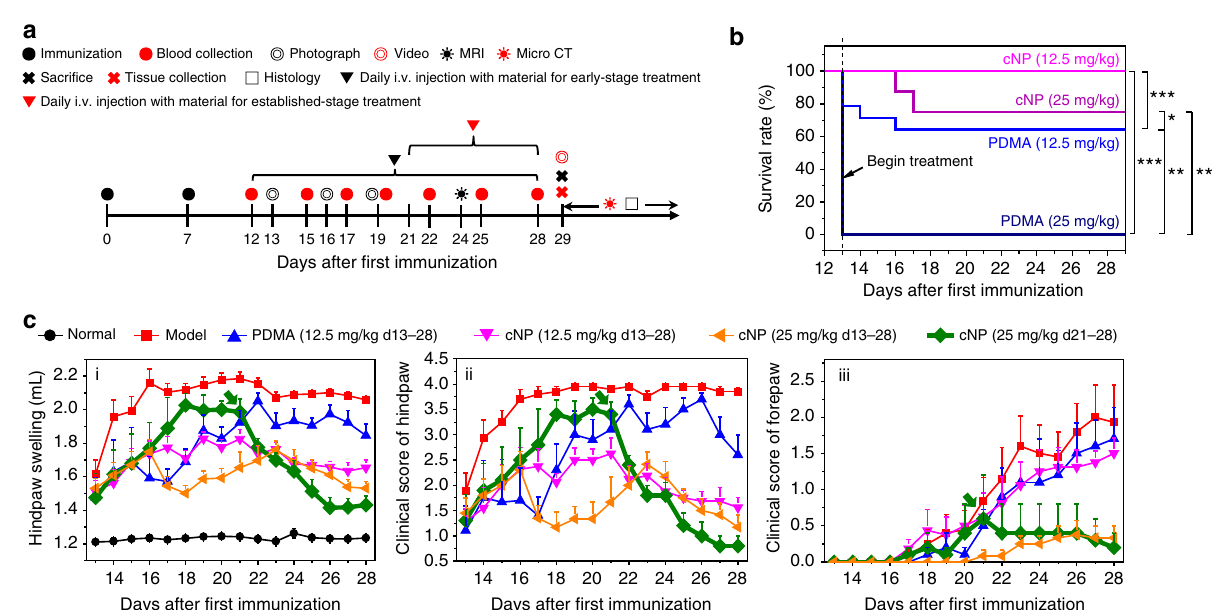
Fig. 4 cNP better alleviates the swelling of joints in the CIA model in both early and established therapeutic treatment. a Experimental schedule of the CIA model study. After immunization with collagen type II and Freund ’ s adjuvant twice (at day 0 and day 7), the CIA model was developed. Then CIA rats were i.v. injected with cationic materials from day 13 to day 28 for the early-stage treatment, or i.v. injected with cNP from day 21 to day 28 for the established- stage treatment. Photos and blood were taken regularly during therapy. Further study was performed after the rats were sacri fi ced at day 29. b Survival curve of different treatment groups from day 13 to day 28 after disease progression. Initial number of rats: n = 5 for PDMA, 25mg/kg; n = 14 for PDMA, 12.5 mg/ kg; n = 16 for cNP, 25mg/kg; and n = 13 for cNP, 12.5mg/kg. Statistical signi fi cance was calculated by a log-rank (Mantel – Cox) test, *0.01 < P < 0.05, **0.001< P < 0.01, *** P < 0.001. c Hindpaw swelling ( ci ), clinical score of hindpaw ( cii ), and forepaw ( ciii ) of rats treated in the early stage or the established stage of RA progression (thick green curve). ( ci ) Average hindpaw swelling was determined daily using a plethysmometer, and ( cii and ciii ) the average clinical score of the hindpaws and forepaws of all rats was evaluated. n = 10 for model, PDMA (12.5mg/kg), cNP (12.5mg/kg), and cNP (25mg/kg) groups. n = 5 for the normal group and cNP groups (25 mg/kg d21 – d28). Thick green curve is highlighted for the established-stage treatment with cNP (25mg/kg). Data were presented as the mean ±